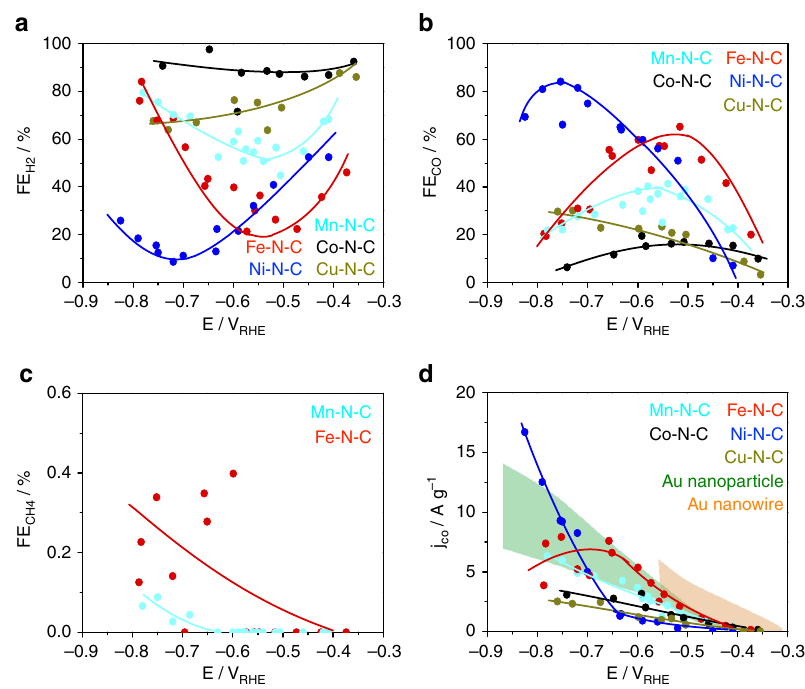
Fig. 4 Catalytic performance and product analysis. a – c Faradaic Ef fi ciencies (FE) vs. applied, IR-corrected electrode potential of a H 2 , b CO and c CH 4 . d Catalyst mass-normalized CO partial currents (mass activity) vs. applied potential for the fi ve M – N – C catalysts compared to state-of-art Au catalysts (performance ranges of Au-nanoparticle and Au-nanowires are shown by fi lled areas 25 – 27 . Lines to guide the eye. Conditions: 60 min at constant electrode potential in CO 2 -saturated 0.1 M KHCO 3 with 0.76 mg cm − 2 M – N – C catalysts loading. Faradaic ef fi ciencies and CO yields after 15 min are shown in Supplementary Fig.